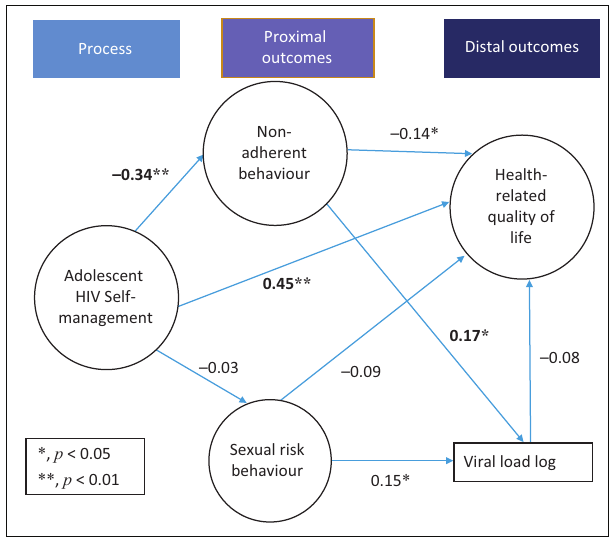
FIGURE 3: Partial least squares structural model.